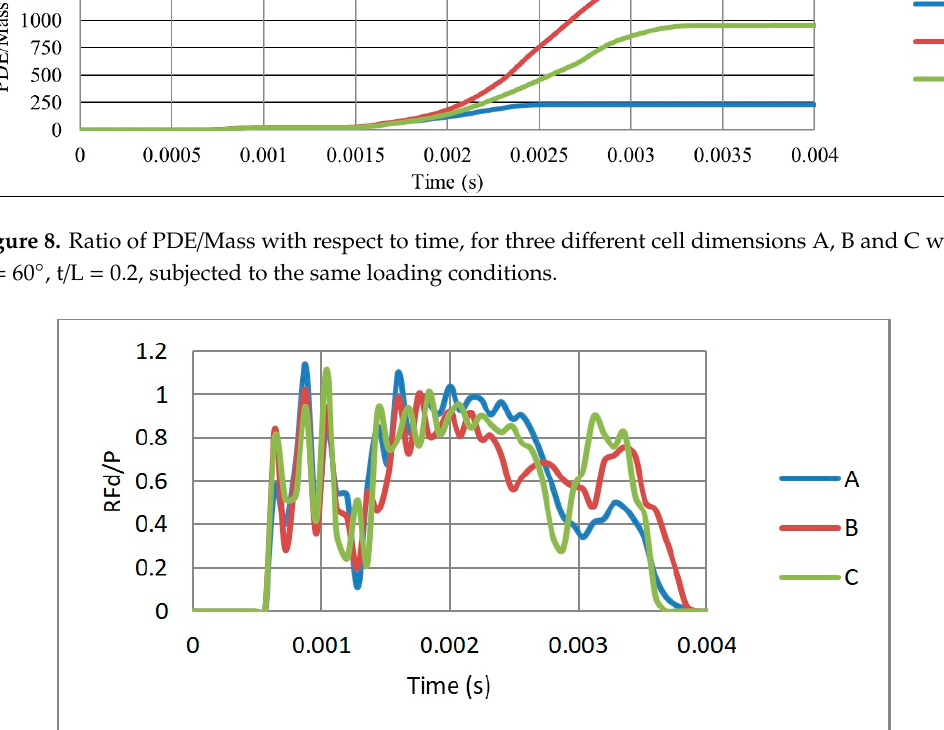
Figure 8. Ratio of PDE/Mass with respect to time, for three different cell dimensions A, B and C with θ = 60°, t/L = 0.2, subjected to the same loading conditions.